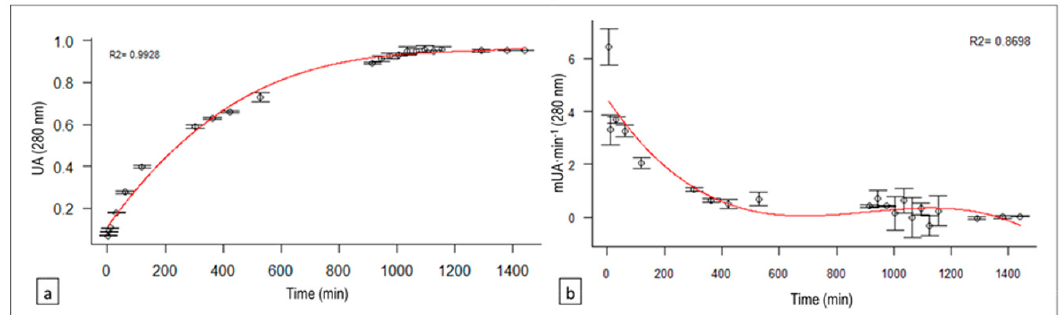
Figure 5. ( a ) Cubic regression model for the relationship between reaction time and absorbance (which correlates with 5% ( w / v ) TCA-soluble peptides) of the C. scolymus L. flower extract on bovine casein. ( b ) Cubic regression model for the relationship between reaction time and proteolysis velocity.